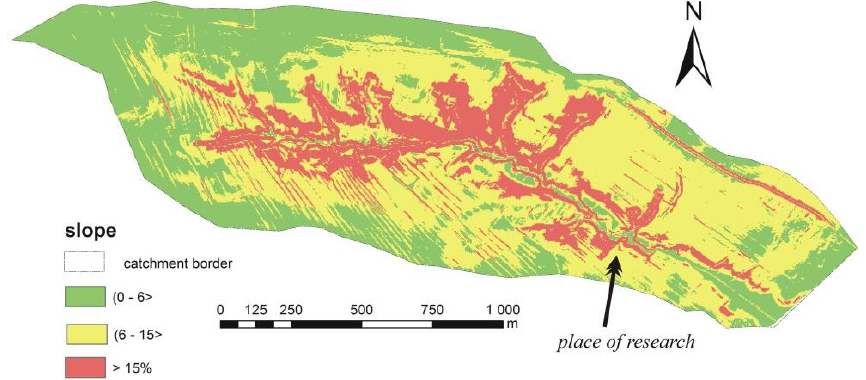
Figure 1. Research location in the agricultural loess catchment in Wielkopole.